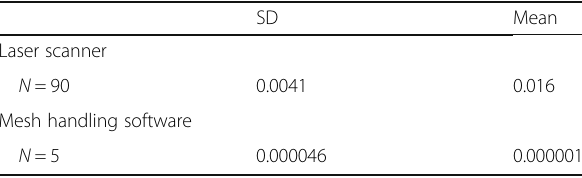
Table 1 Repeatability results for the reference scanner and the CloudCompare